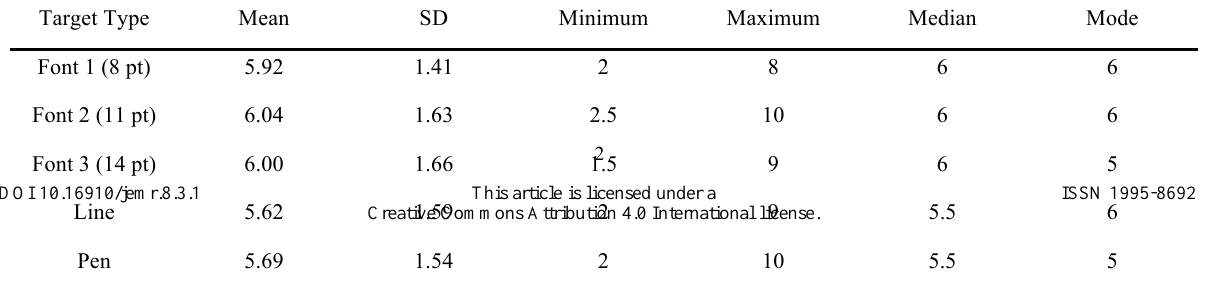
Descriptive Statistics for NPC by Target Type letters (8, 11, and 14 pt font) in reduced Snellen chart